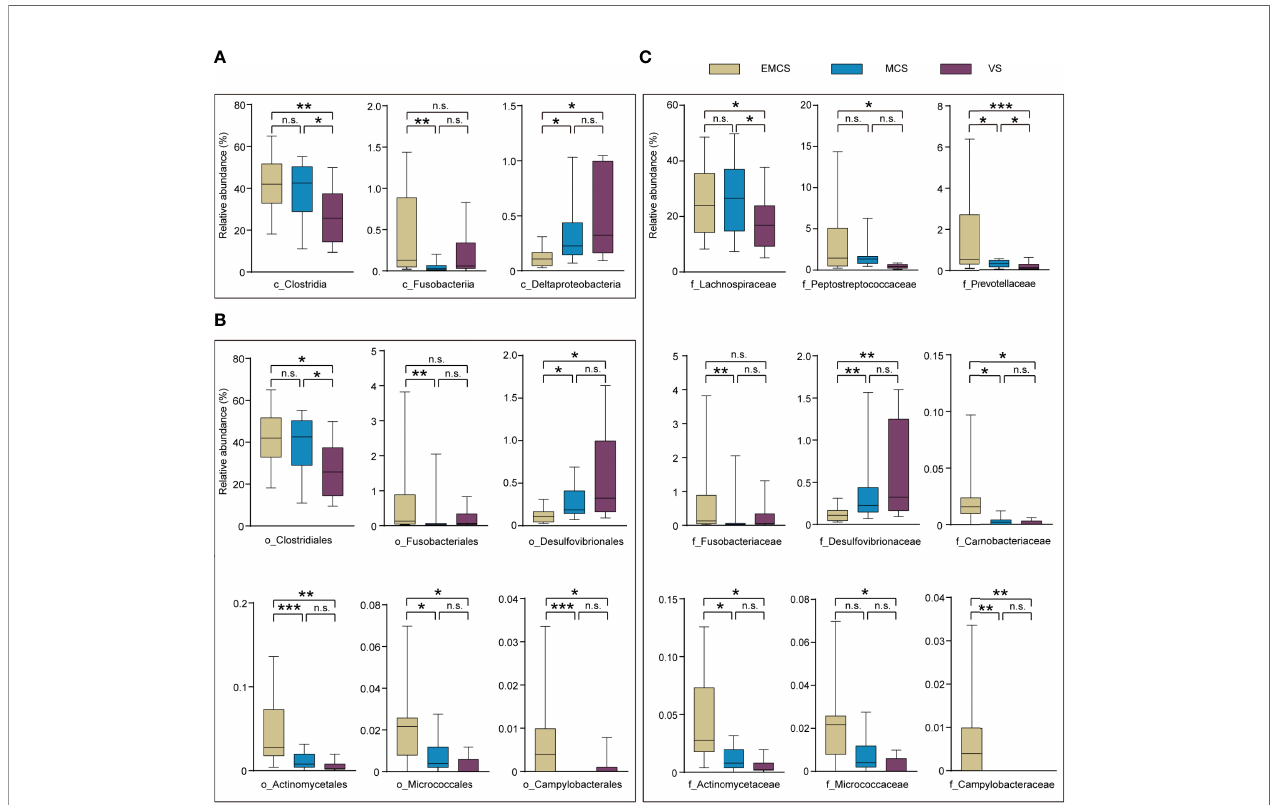
FIGURE 2 | Taxonomic differences of the class, family, and order levels in the fecal microbiota among EMCS, MCS, and VS patients. (A – C) Comparison of the relative abundance rates at the class level (A) , order level (B) , and family level (C) across the three groups. Each box represents an interquartile range ( fi rst and third quartiles) of taxon abundance, and the middle line corresponds to the median abundance. No box indicates that the fecal microbiota cannot be detected in the group. P -values were corrected using FDR. * p < 0.05, ** p < 0.01, *** p < 0.001; n.s. , no signi fi cant difference. c , class; f , family; o , order; EMCS , emerged from minimally conscious state; MCS , minimally conscious state; VS , vegetative state; FDR , false discovery